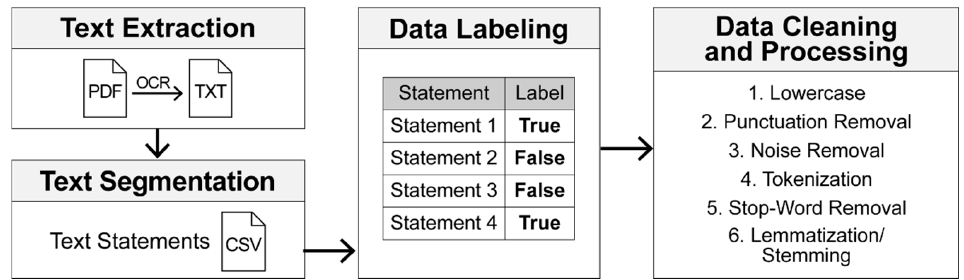
Figure 2. Data preparation and pre-processing during extraction module development.